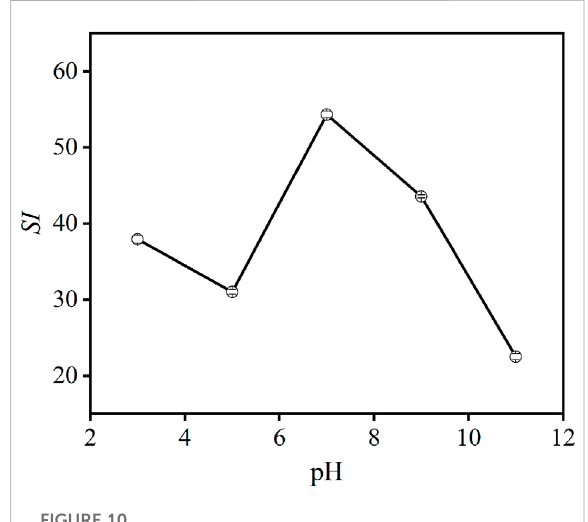
FIGURE 9 Effect of frother dosage on SI of carbon anode slag fl otation (grinding time 40 min, feed solid concentration 140 g/L, collector dosage 1,000 g/t).